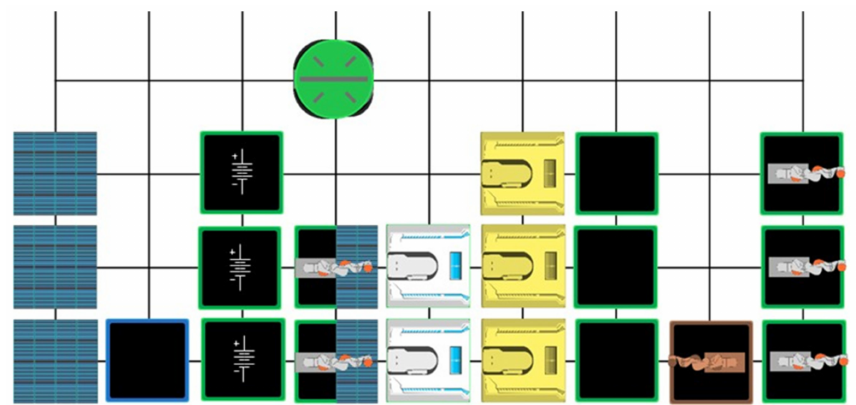
Figure 6. Multi-row platform layout by platform type.